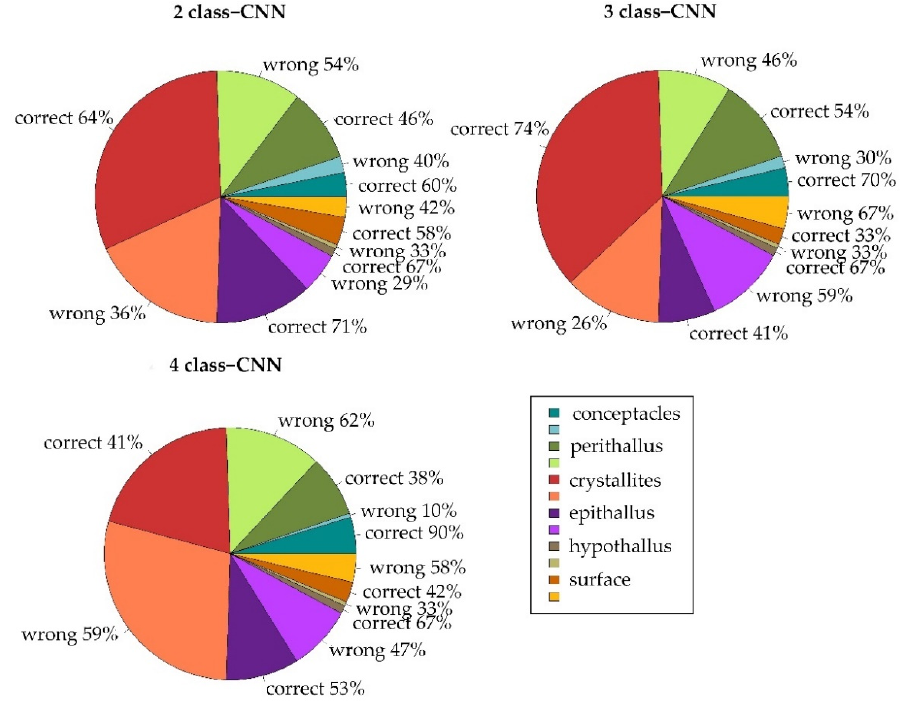
Figure 4. Total number of SEM images assigned to different categories that have been classified in the 2, 3 and 4 class-CNNs. Percentages within each category indicate the proportion between images correctly and wrongly classified.